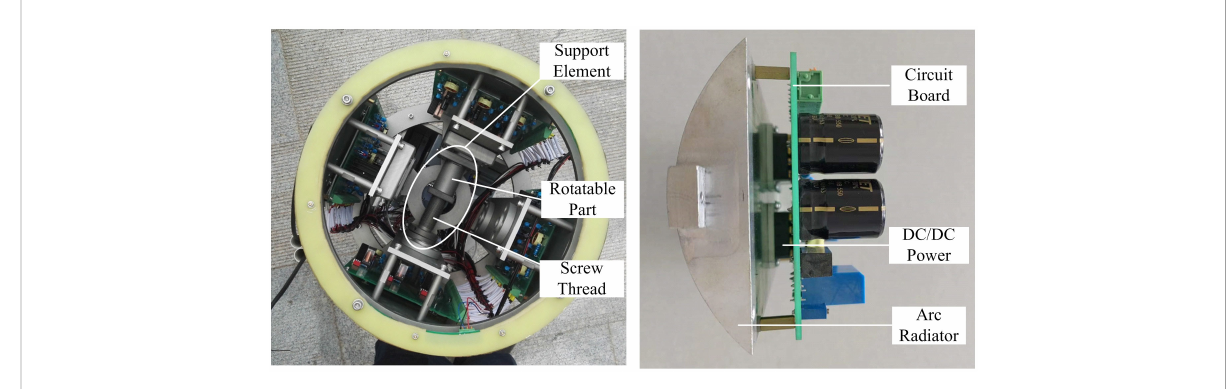
FIGURE 4 Mounting structure for